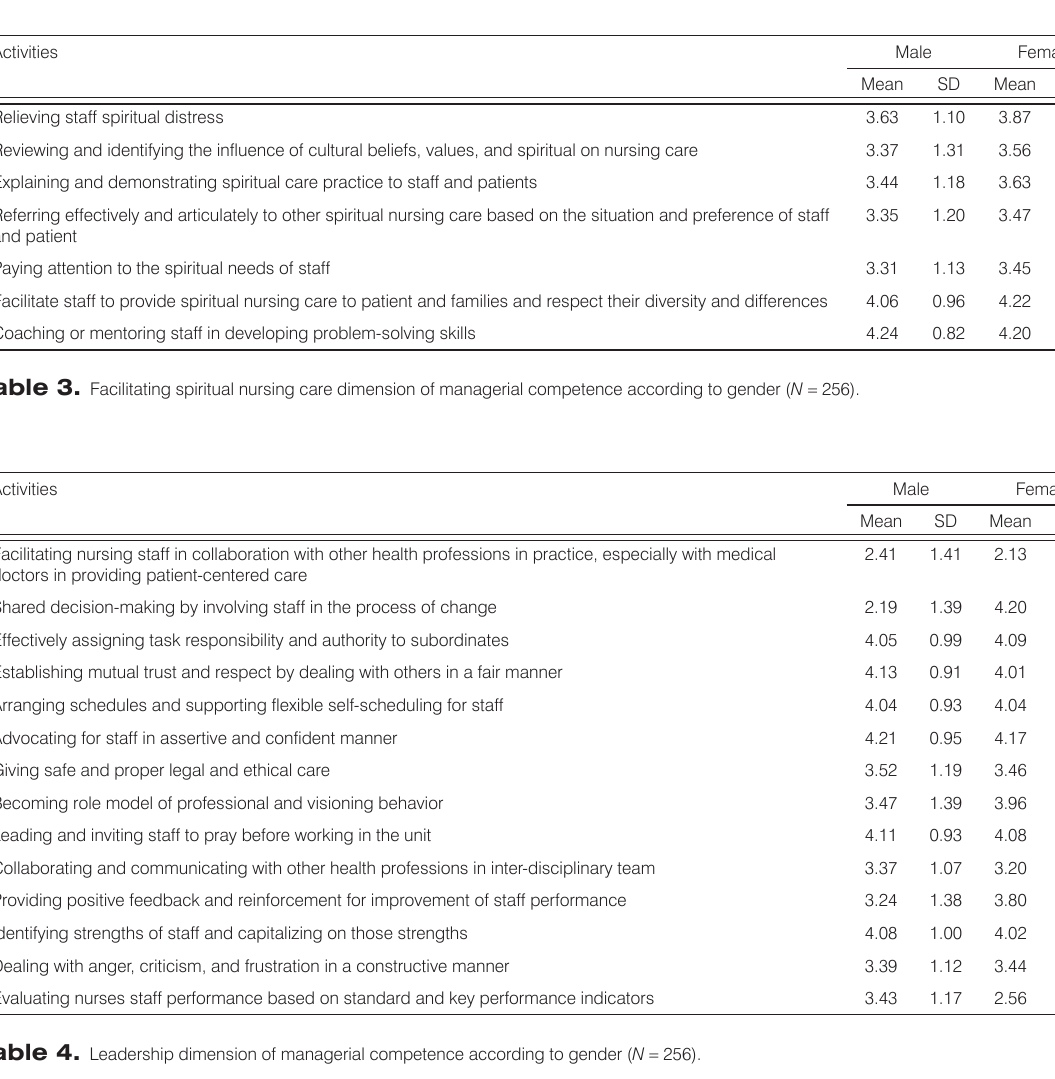
Table 4. Leadership dimension of managerial competence according to gender ( N =